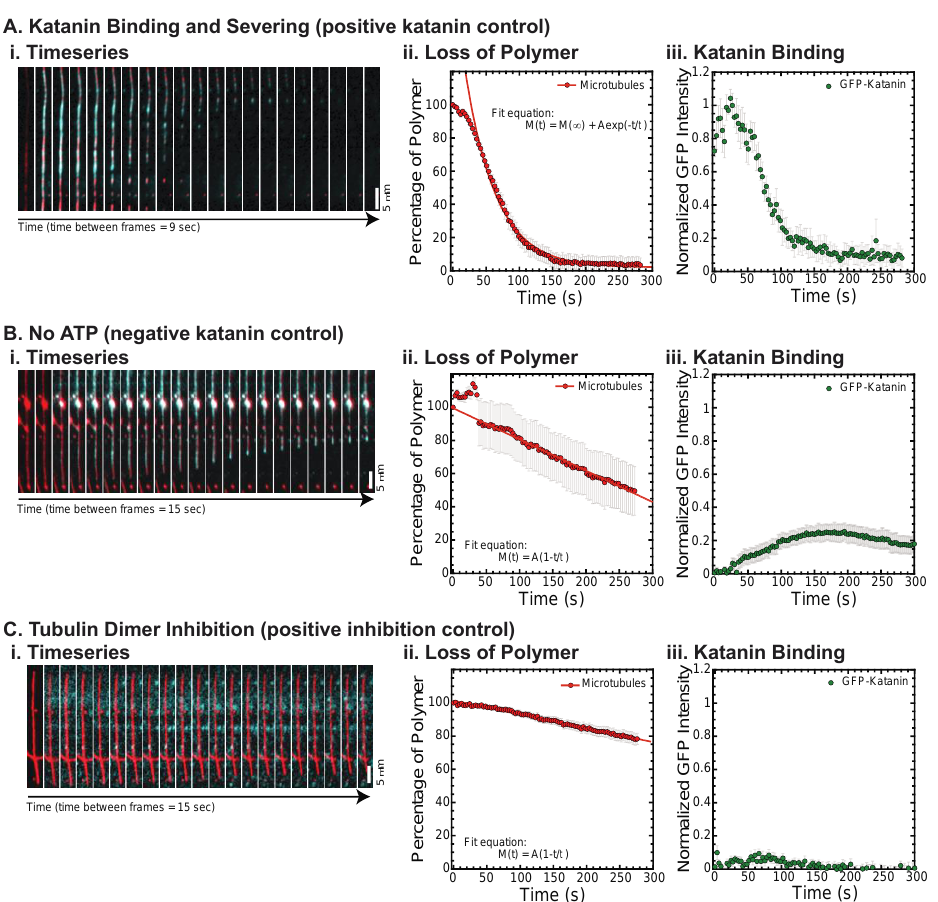
Figure 1. Example data, quantification, and controls. ( A ) Katanin in the presence of ATP is able to bind and sever microtubules. This daily control demonstrated that katanin was active. ( i ) Time series of a representative movie showing GFP-katanin binding (cyan) along rhodamine-labeled microtubule (red), becoming severed and losing polymer throughout the filament over time. Scale bar is 5 µ m. Time between consecutive frames is 9 s. ( ii ) Quantification of the loss of polymer measured the signal on the microtubule and the noise 5 pixels away to determine the S/N-1 and then normalized by the initial time data. Loss of polymer data was fit with an exponential decay equation. Best fit parameters for these data are given in Supplemental Information Table S1. ( iii ) GFP-katanin binding was quantified in the same way and the S/N-1 was normalized compared to the same day control with ATP (these data), which is why these data have a maximum of 1. ( B ) Katanin in the absence of ATP is able to bind, although not as well. This daily control demonstrated that katanin ATPase activity was responsible for severing. ( i ) Time series of a representative movie showing GFP-katanin binding (cyan) along rhodamine-labeled microtubule (red), not severing, but losing polymer from the ends, depolymerizing. Scale bar is 5 µ m. Time between consecutive frames is 15 s. ( ii ) Quantification of the loss of polymer as in part ( A ). Loss of polymer data was fit with a linear approximation to an exponential decay equation. Best fit parameters for this data are given in Supplemental Information Table S1. ( iii ) GFP-katanin binding was quantified in the same way and the S/N-1 was normalized compared to the same day control with ATP. ( C ) Katanin in the presence of ATP and 2 µ M tubulin dimers, which inhibit binding and severing. ( i ) Time series of a representative movie showing GFP-katanin does not bind well (cyan) along rhodamine-labeled microtubule (red). Scale bar is 5 µ m. Time between consecutive frames is 15 s. ( ii ) Quantification of the loss of polymer as in part (A). Loss of polymer data was fit with a linear approximation to an exponential decay equation. Best fit parameters for these data are given in Supplemental Information Table S1. ( iii ) GFP-katanin binding was quantified in the same way and the S/N-1 was normalized compared to the same day control with ATP. Representative movies in Supplemental Information Movies S1 and